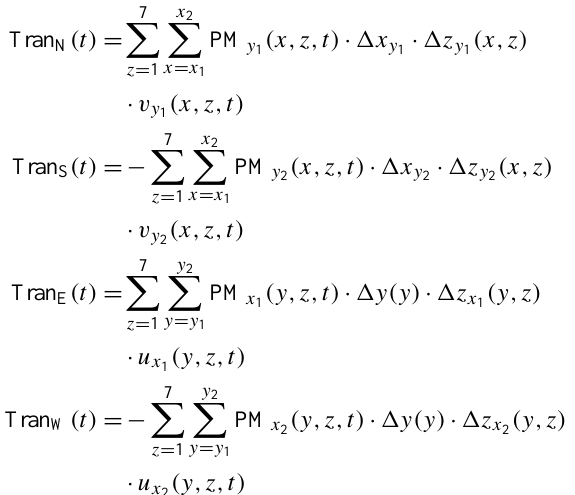
( v) values were representative of a southerly wind, and